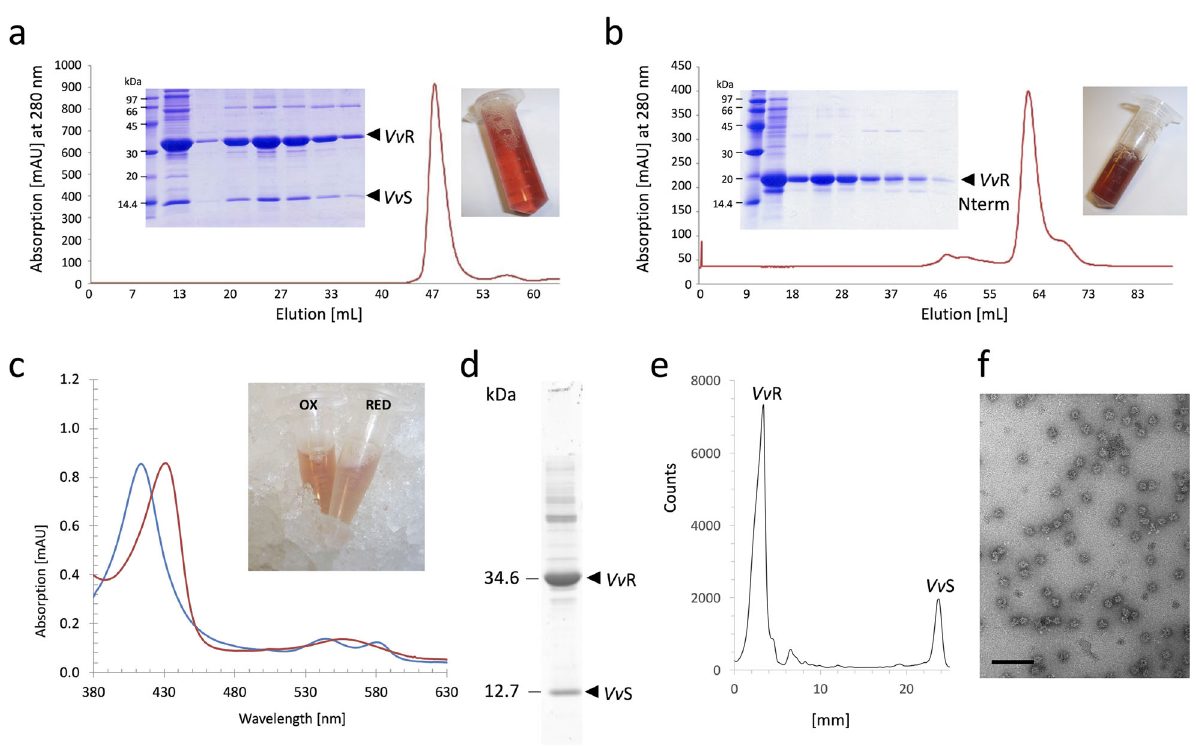
Fig. 2 Biochemical characterization of the Vv RsbR: Vv RsbS complex. Size exclusion chromatography pro fi les of the Vv RsbR: Vv RsbS complex ( a ) and the Vv RsbR N-terminal domain ( b ). Insets show Coomassie-stained fractions of the elution maxima after separation by SDS PAGE and the puri fi ed protein after concentration: Vv RsbR: Vv RsbS complex (13 mg/mL) and VvRsbRN-terminal domain (amino acid residues 1 – 165, 15 mg/mL). c Absorption spectra of oxygenated (blue line) and deoxygenated (red line) forms of the Vv RsbR: Vv RsbS complex. Deoxygenated Vv RsbR: Vv RsbS samples were prepared by adding sodium dithionite to the protein solutions. Spectra were obtained using a 1 cm path length quartz cuvette and a Biochrom Libra S22 UV-Vis spectrophotometer. The inset shows photographs of protein solutions in oxygenated (OX) and reduced (RED) states. d Puri fi ed Vv RsbR: Vv RsbS stressosome complex separated by SDS PAGE (uncropped gel lane) and stained with Krypton (Thermo Scienti fi c). The gel was imaged with a Typhoon fl uorescence scanner, with excitation at 532 nm and emission recorded at 560 nm. Band intensities were quanti fi ed with ImageQuant ( e ). The calculated ratio between Vv RsbR and Vv RsbS was 2.4:1. The uncropped gel is shown in Supplementary Fig. 18b. Electron micrographs of negative stained puri fi ed Vv RsbR: Vv RsbS complexes showed homogenously distributed particles ( f ). The size bar represents 100 Fig. 5c, Supplementary data 2). The number of proteins with